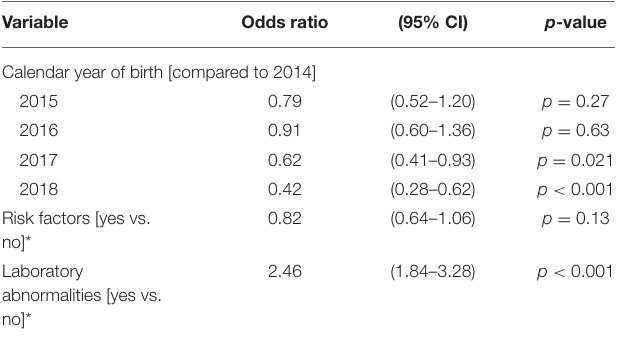
TABLE 5B | Ordered logistic regression: duration of antibiotic therapy by calendar year of birth, risk factors, and laboratory abnormalities.